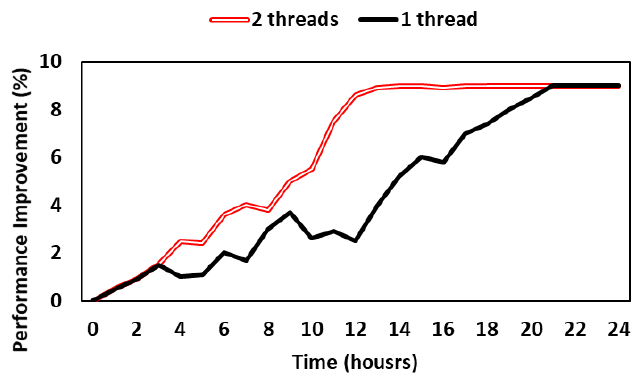
Figure 8. The degree of performance improvement according to time and number of threads of online learning in the dynamic network environment.